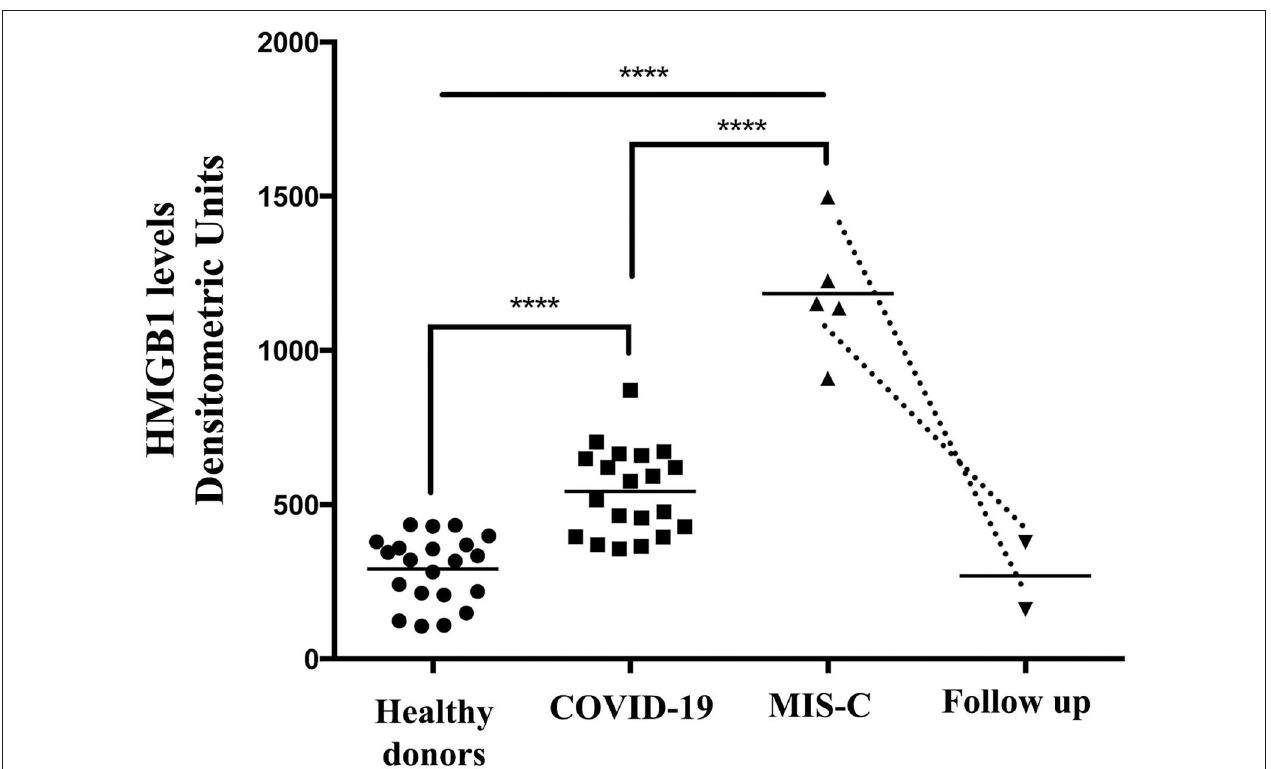
FIGURE 2 | High-mobility group box 1 levels were detected by Western blot in the sera of patients with MIS-C ( n = 5), children with a recent history of COVID-19 (n = 20), healthy donors ( n = 21), and in two of the five children that performed a follow-up. Densitometric values of HMGB1 levels are represented and summarized by Scatter plot analysis. Serum HMGB1 levels from both MIS-C children and pediatric subjects with a recent history of COVID-19 were compared to healthy donors. **** p <